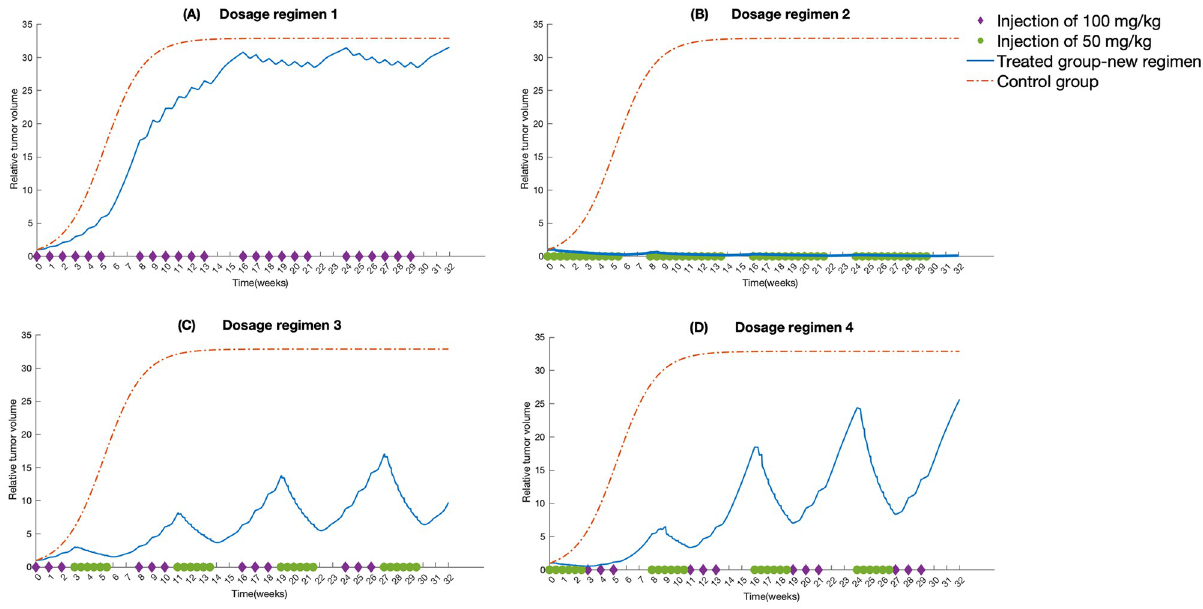
Fig 6. The simulation results associated with the four novel dosage regimens. The regimens under consideration are (A) 100 mg/kg on day 1 of weeks 1 to 6 of a eight-week cycle, for a total of 4 cycles; (B) 50 mg/kg twice a week of weeks 1 to 6 of a eight-week cycle, for a total of 4 cycles; (C) 100 mg/kg on day 1 of weeks 1 to 3 followed by 50 mg/kg twice a week of weeks 4 to 6, for a total of 4 cycles (32 weeks); (D) 50 mg/kg twice a week of weeks 1 to 3 followed by 100 mg/kg on day 1 of weeks 4 to 6, for a total of 4 cycles (32 weeks). Red dash line: model simulation of control; blue solid line: simulation results associated with the four dosage regimens; purple diamond-shaped dot: time of injection of 100 mg/kg 5FU; green round dot: time of injection of 50 mg/kg 5FU.